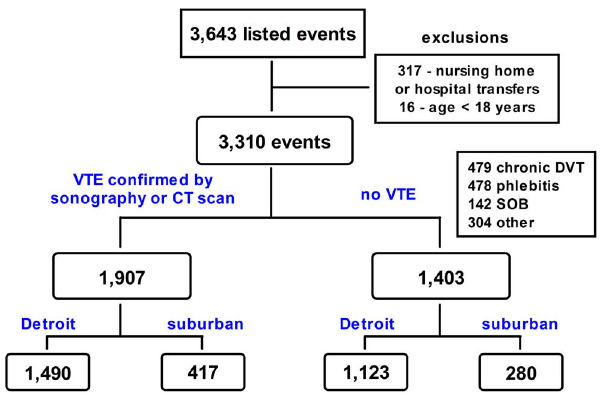
Figure 1. Case inclusion flow-chart. CT – computed tomography; DVT – deep vein thrombosis; SOB – shortness-of-breath; VTE – venous